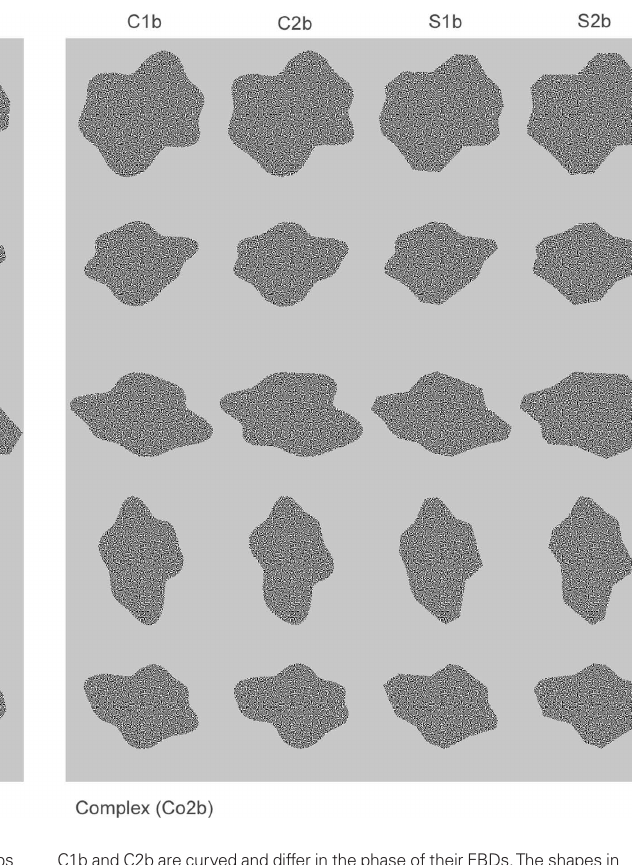
Figure 2 | Stimulus set used in experiment 2. The set contains two groups differing in complexity; Co1b and Co2b (roughly corresponding in complexity with the shapes in Co1 and Co2 of the stimulus set in Figure 1 ). The rows contain five calibrated sets of shapes that can be used to compare neural sensitivity to either changes in the phase of the FBDs or the presence of curved versus straight contours, as a function of complexity. The shapes in columns